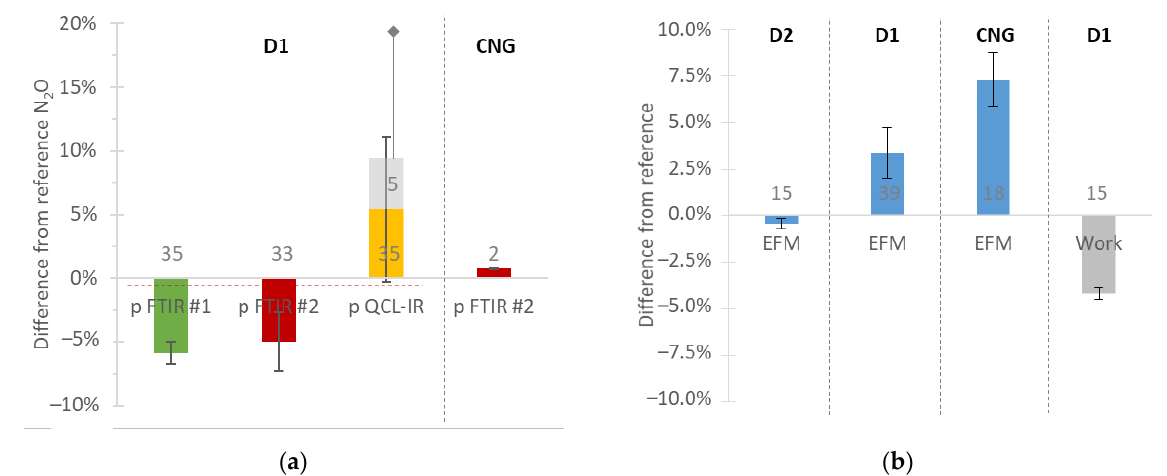
Figure 9. Comparisons of instruments: ( a ) N 2 O; ( b ) flow and work. Error bars are one standard deviation of the number of repetitions given in/on the bars. CNG = compressed natural gas engine; D = diesel engine; EFM = exhaust flow meter; FTIR = Fourier transform infrared; p = portable; PEMS = portable emissions measurement system; QCL-IR = quantum cascade laser infrared.